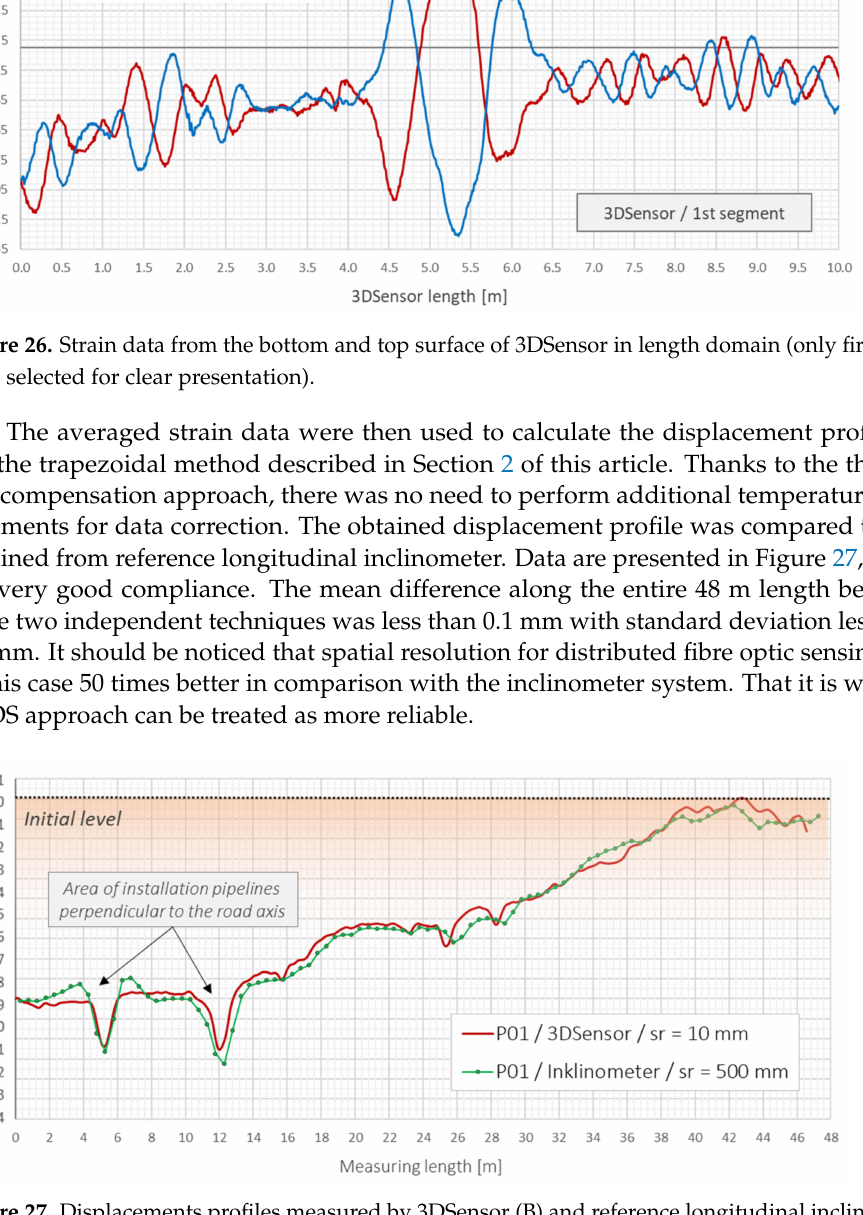
Figure 27. Displacements profiles measured by 3DSensor (B) and reference longitudinal inclinometer over entire measurement length of 48